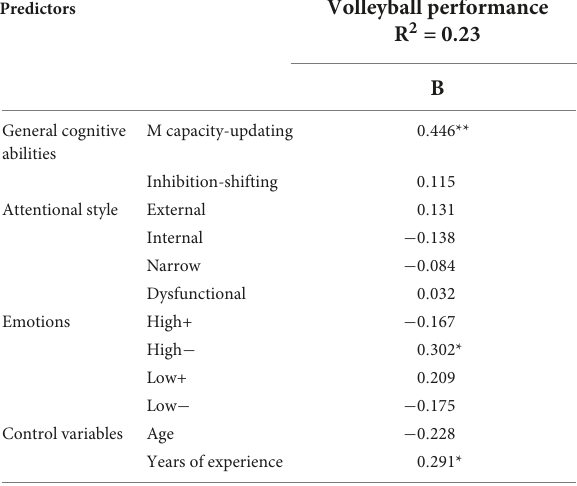
TABLE 6 Regression analysis with the volleyball performance as the dependent variable, and all predictors and control variables entered in the